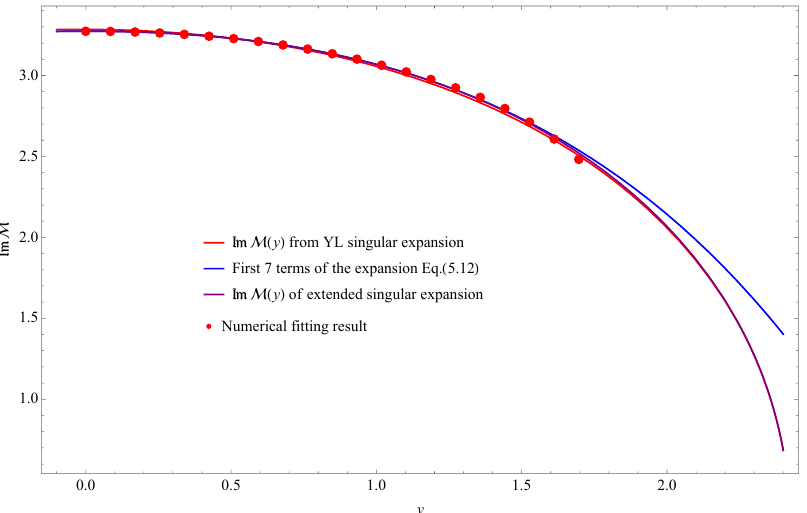
Figure 17 . Plots of = m M ( y ) above the upper edge of YL branch cut, 0 < y < Y 0 . The red, blue and purple solid lines correspond to the analytical continuation via eq. (5.6), eq. (5.12) and eq. (5.15). The red bullets are given by fitting the imaginary part of ∆ E ( R ) for ξ 2 < − ξ 2